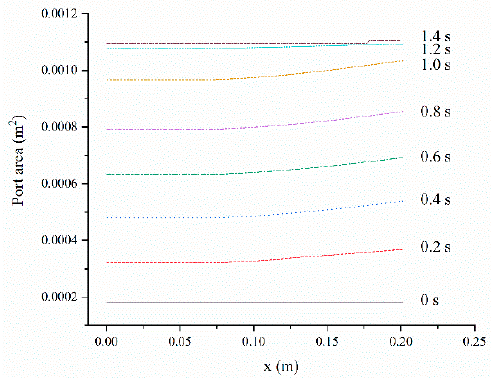
Figure 10. Port area at different times.